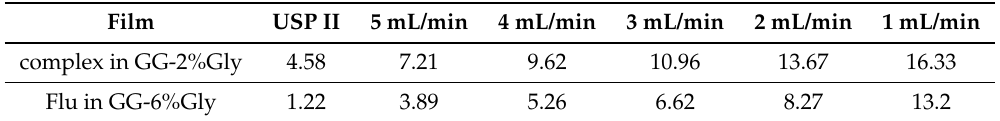
Table 3. Time t 80% [min] required for attaining the 80% release in the MFTD ( Q = 1–5 mL/min) and USP II apparatus for two different film formulations: complex Flu/HP- β -CD in GG-2%Gly and Flu in GG-6%Gly.